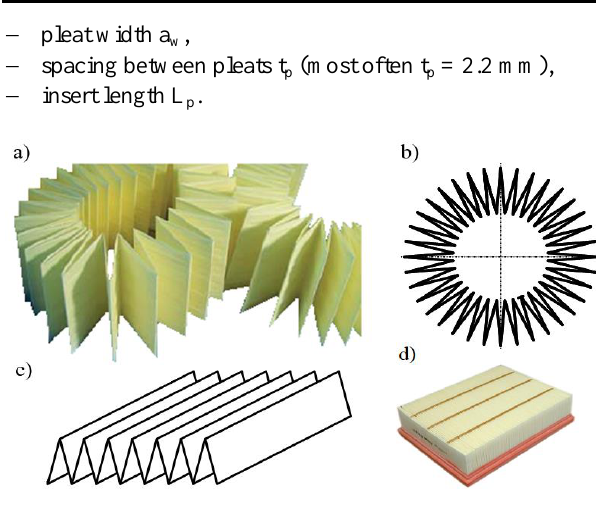
Fig. 3. Shaping the filter paper: a) paper after pleating, b) shaping into a multi-arm star, c) shaping into a panel, d) panel filter cartridge